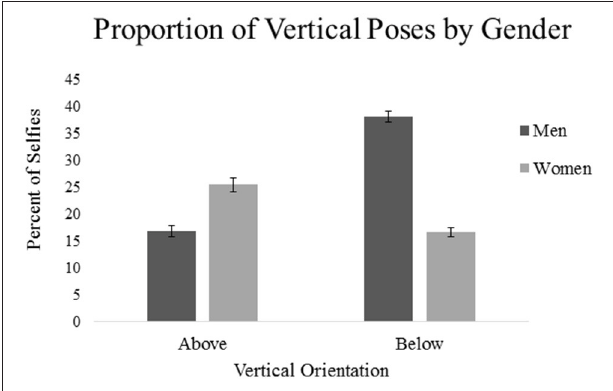
FIGURE 2 | Proportion of vertical poses ( ± SE) based on gender. The figure illustrates the proportional difference between men and women’s tendency of taking vertical selfies; that is, when excluding neutral poses, men displayed a bias for portraits of selfies from below, whereas women alternatively presented an